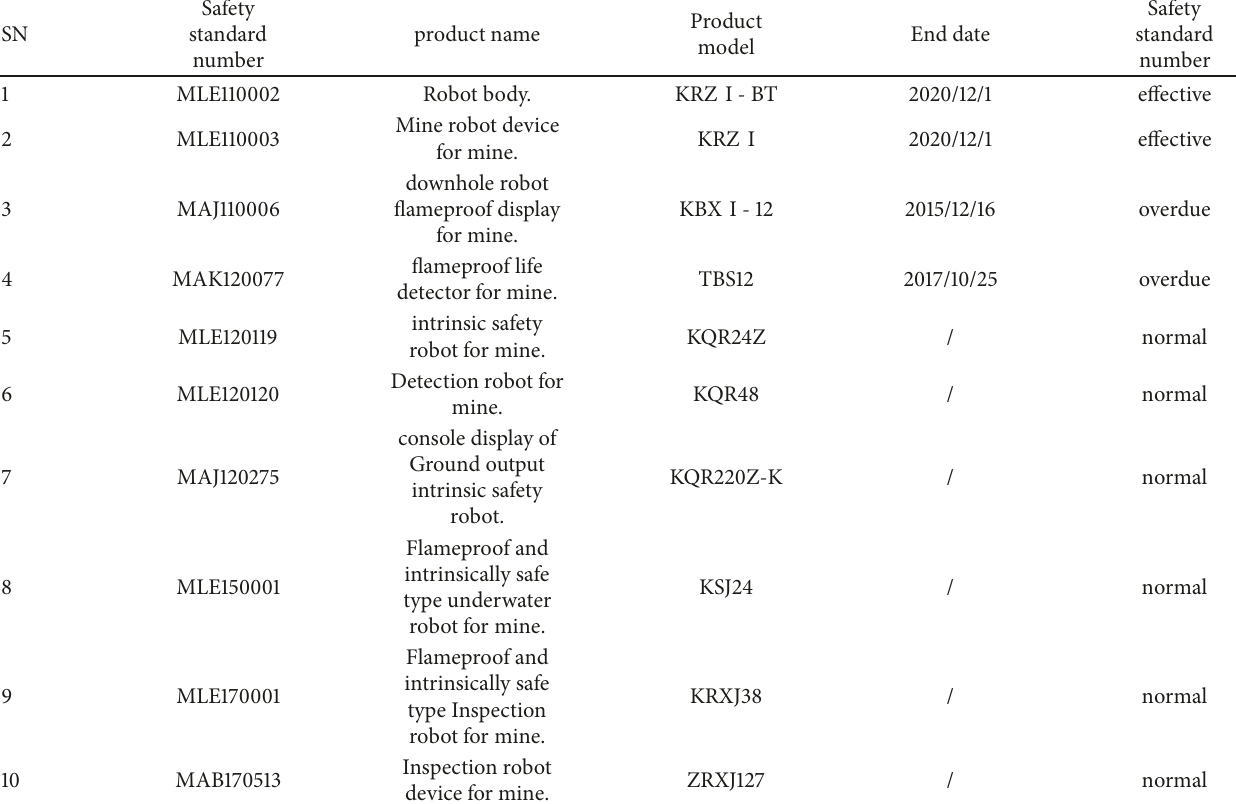
Table 2: Robot products of Kaicheng company with safety